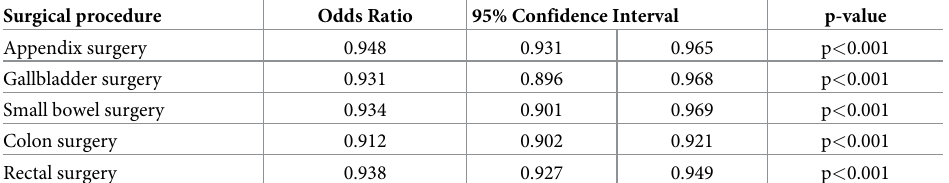
Table 2. Odds ratio of the 10% increase in the proportion of laparoscopic procedures for the surgical site infection